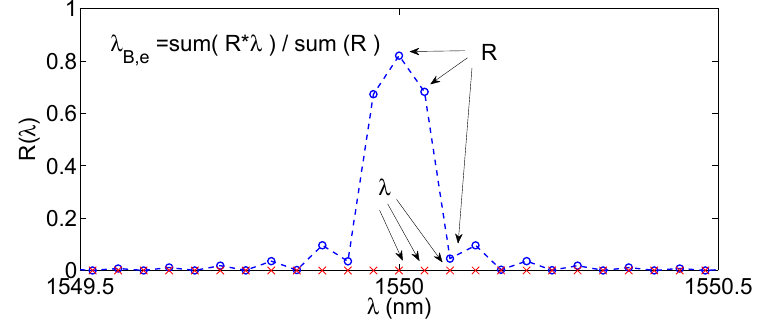
Figure 6. Sketch of the centroid peak-tracking method.